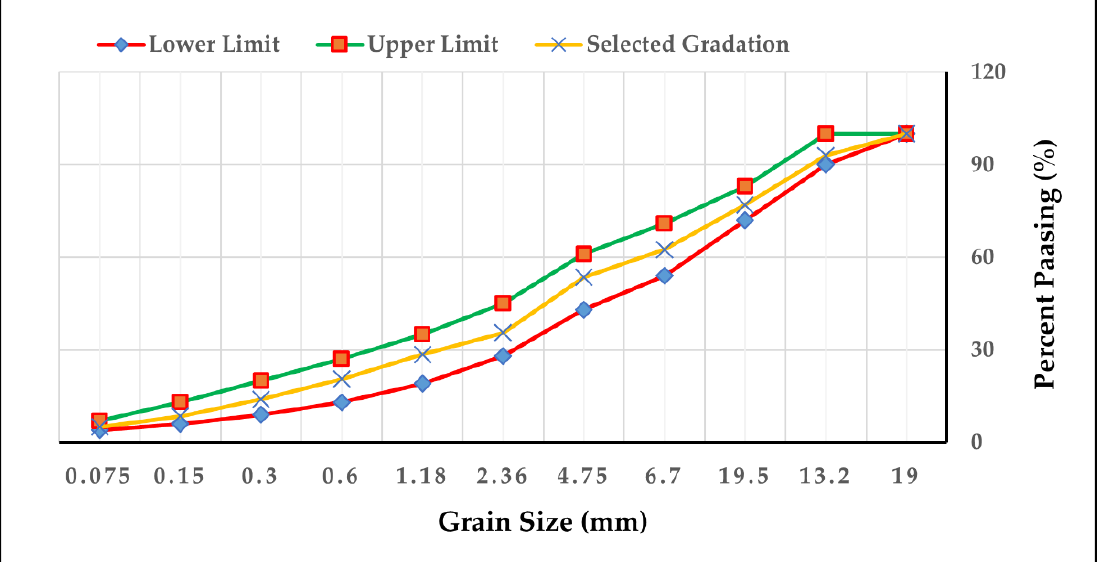
Figure 4. Aggregates gradation curve.